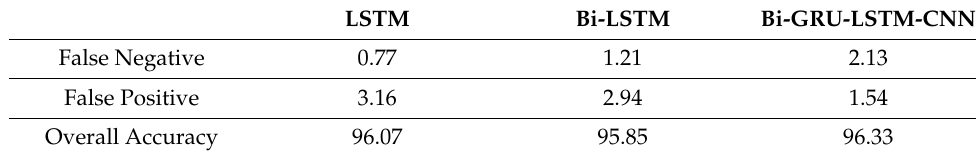
Table 4. False negative vs. false